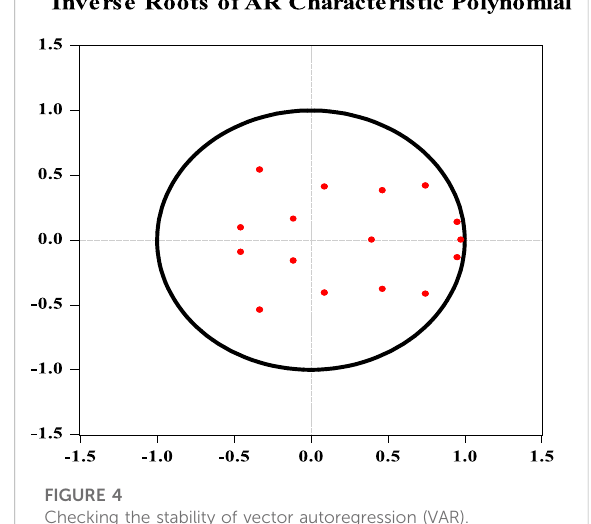
FIGURE 4 Checking the stability of vector autoregression